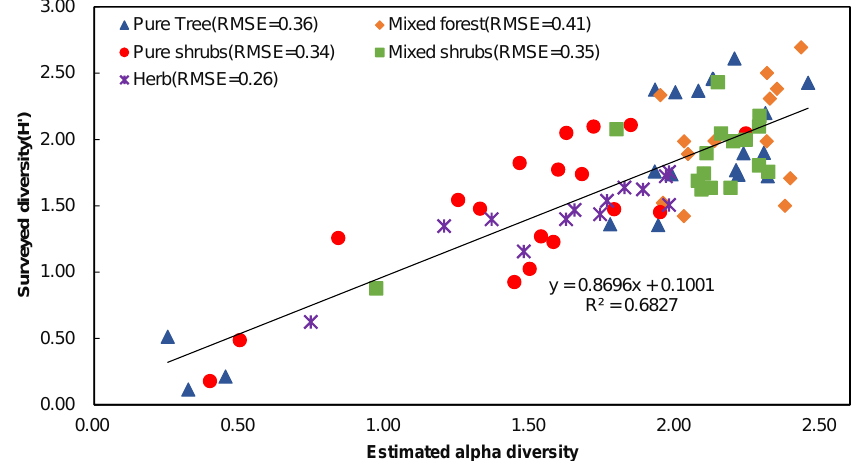
Figure 4. The spectral diversity of different vegetation community types in 2020. Among the community types, herbs had the lowest fitting error ( RMSE = 0.26), while the values of alpha diversity ranged from 1.2 to 2.0, indicating that the spectral diversity of herbs was more homogeneous than the spectral diversity of other community types analyzed here. The Landsat imagery and BiodivMapR package in R software had a better capability to reflect the diversity of homogeneous herbs, while the fitting errors of trees ( RMSE = 0.38) and shrubs ( RMSE = 0.34) were not as good. For trees, the RMSE between estimated alpha diversity and surveyed diversity was 0.36 for the pure tree community and 0.41 for mixed forest. The values of estimated alpha diversity for mixed forests were generally high, indicating that the level of diversity was higher and more variable for mixed forests than for pure tree stands. The RMSE s of mixed shrubs and pure shrubs were very similar, and the estimated alpha diversity values of pure shrubs were in a broad range from 0.4 to 2.0, while the values of mixed shrubs were concentrated between 2.0 and 2.5; this indicated the higher richness of the shrub community in the study area and the significant differences in diversity levels. 3.3. Spatial and Temporal Dynamics of Alpha Diversity Figure 5 shows the alpha diversity of the study area in 1990, 2000, 2010, and 2020. The values of alpha diversity in 2020 were concentrated in the range of 0.24 – 2.42, with a mean and standard deviation of 2.00 and 0.17, respectively. This was in contrast to 2010, showing an increase of 0.08 in the mean and a decrease of 0.23 in the standard deviation. Meanwhile, in 2000, the mean and standard deviation were 1.83 and 0.23, respectively, and in 1990, they were 1.90 and 0.23, respectively. During the 30 years from 1990 to 2020, the spatial extent of the area where alpha diversity increased was 567.95 km 2 , accounting for 62.55% of the study area. Spatially, the areas with an increase in diversity were mainly located in the northwestern and central parts of the study area, with a significant increase in alpha diversity in the desert areas situated in the northeastern region and along both sides of the river, as well as in a small area overlapping with part of the mining area. The increase in diversity is mainly caused by many mine restoration projects including reforestation, land reclamation, water and soil conservation. The area of decreased diversity covered 340.02 km 2 , accounting for 37.45% of the total area and was spatially distributed in the southeastern part of the study area, especially in the area where surface mines exist.